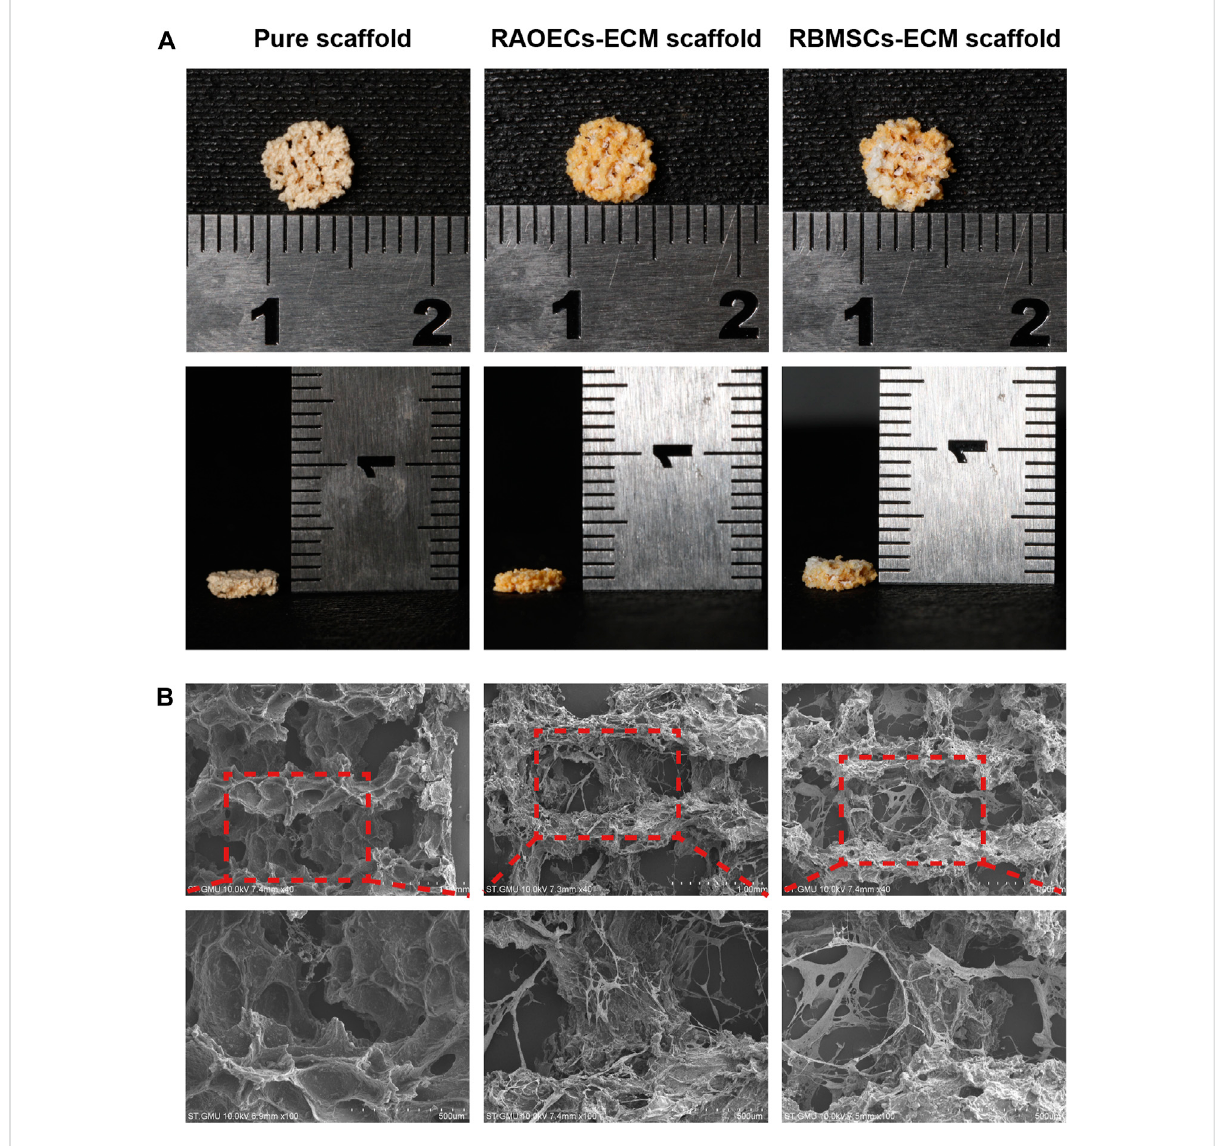
FIGURE 1 Morphological characteristics of the pure scaffold, RAOECs – ECM scaffold and RBMSCs – ECM scaffold. (A) Optical images of fabricated scaffolds with cylindrical shapes were observed from the top view and side view. (B) SEM images at various magni fi cations showed the surface morphology and microstructure of the